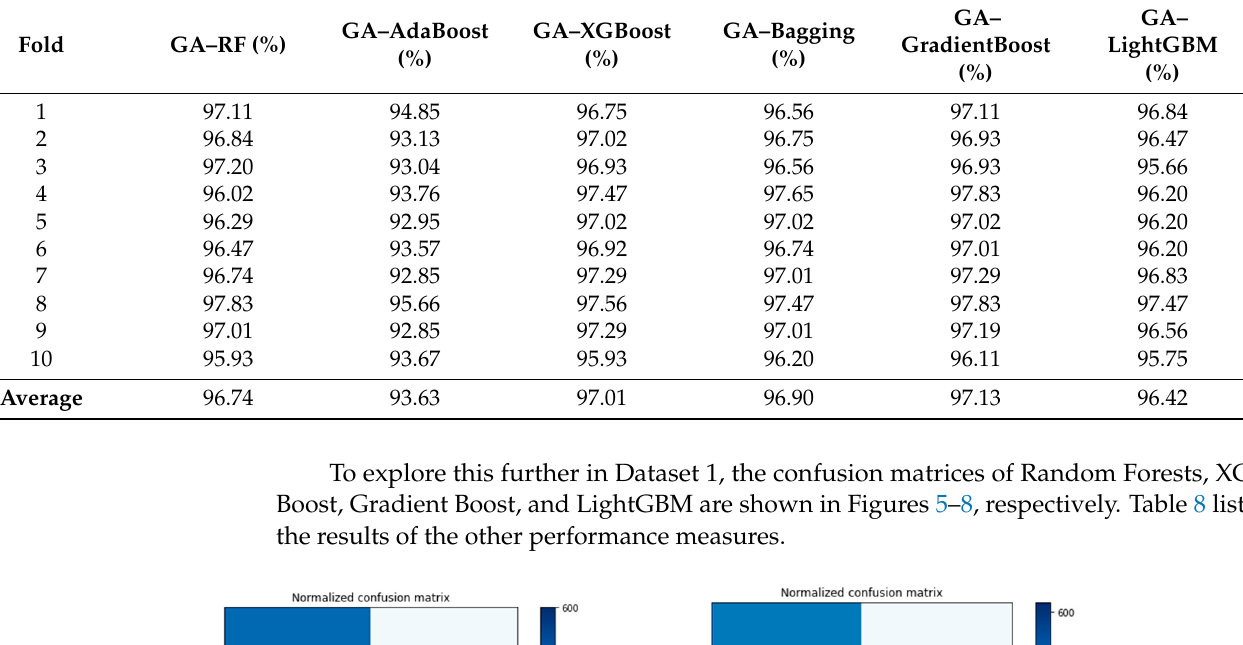
Figure 5. A normalized confusion matrix of Random Forests for phishing website and legitimate website classification: ( a ) with default parameters; ( b ) with optimized parameters for Dataset 1.